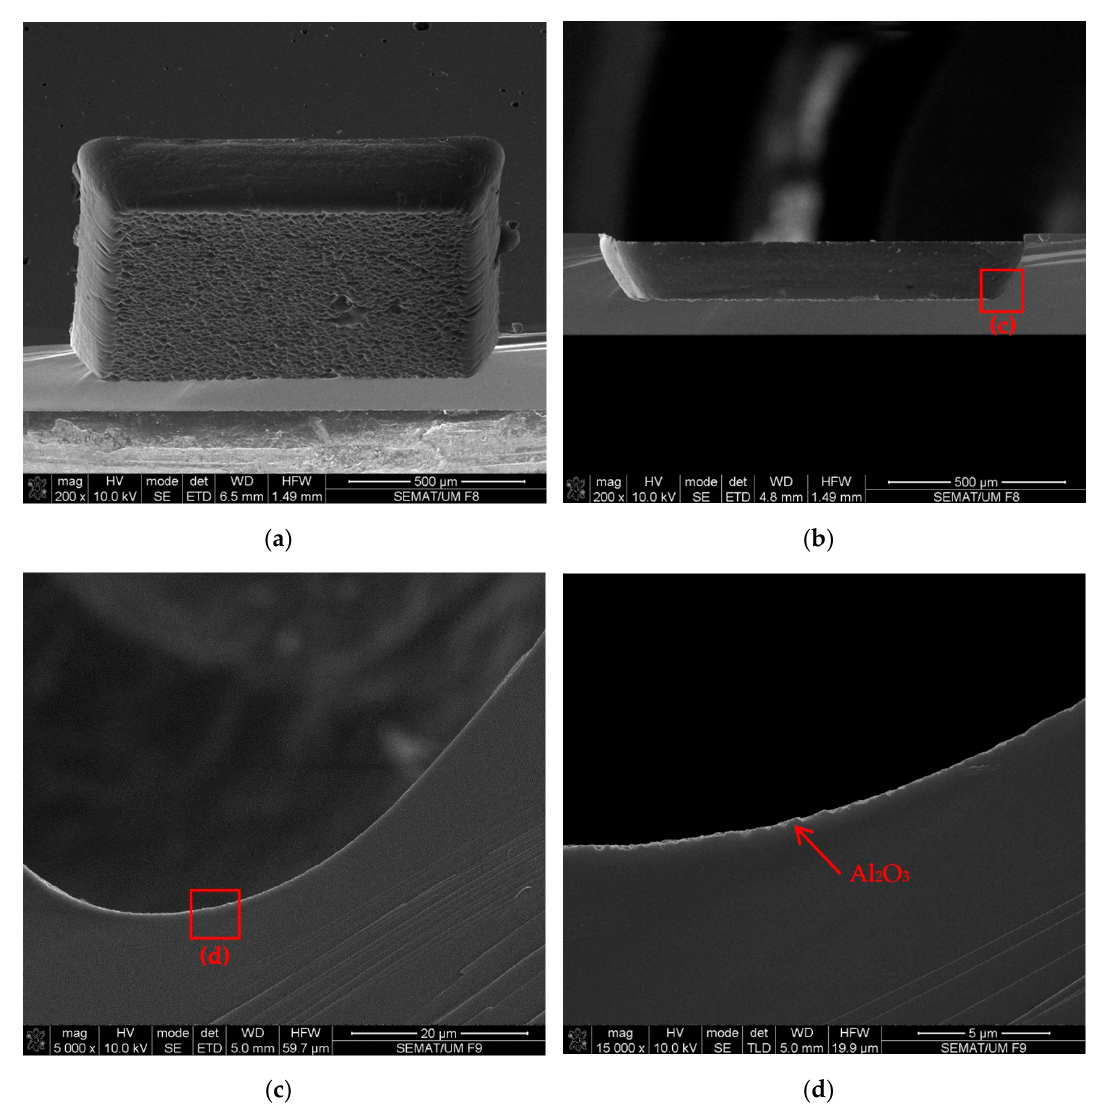
Figure 7. SEM analysis: ( a ) 20-degree angled horizontal-cut view of a squared cavity with 1 mm 2 of area; ( b ) horizontal-cut view of a 180 µm-deep cavity in a 300 µm-thick Si wafer; ( c ) PEALD Al 2 O 3 ultra-thin film conformity in the cavity wall; ( d ) detail of the 39 nm PEALD Al 2 O 3 ultra-thin film (white surface coating).